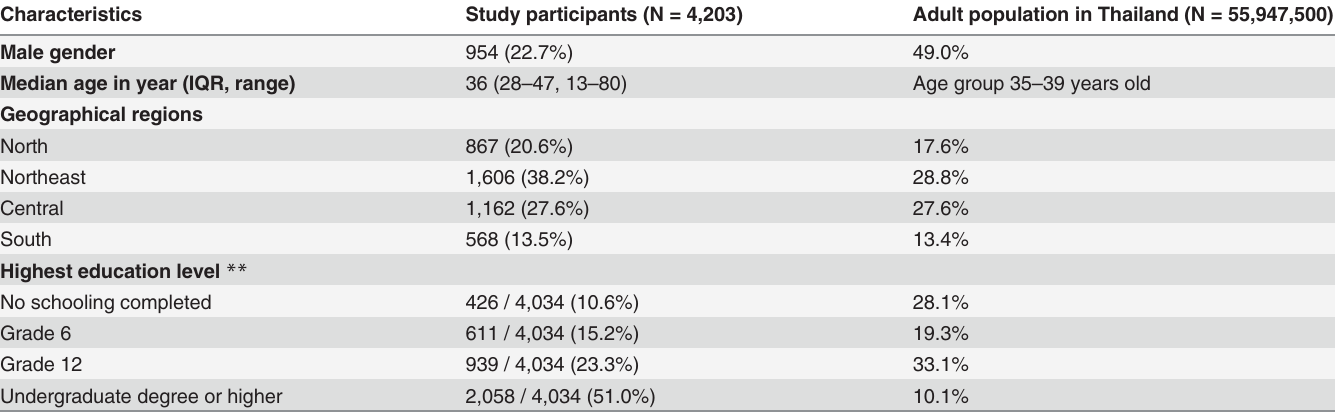
Table 1. Characteristics of 4,203 adult participants who completed the questionnaire about awareness and knowledge of common infectious dis- eases in Thailand. Characteristics